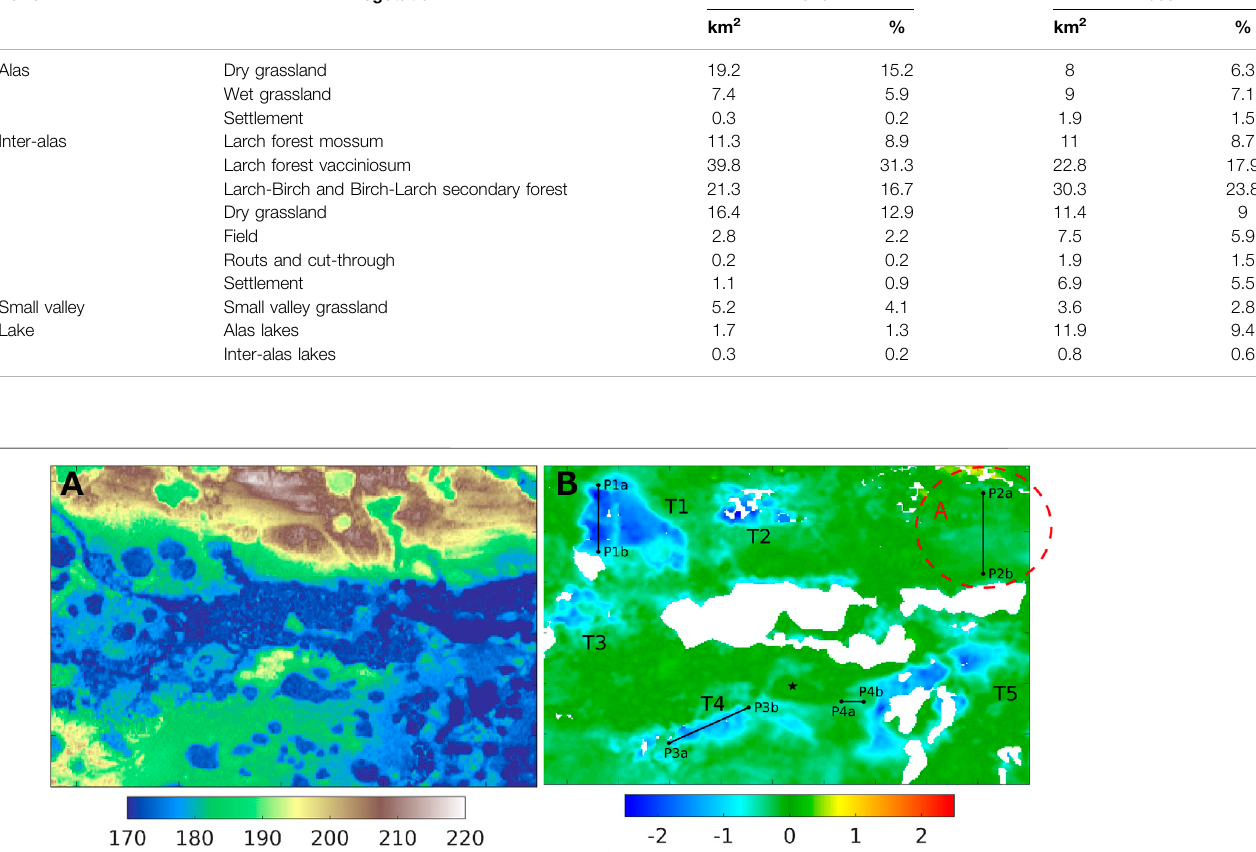
Frontiers in Earth Science |